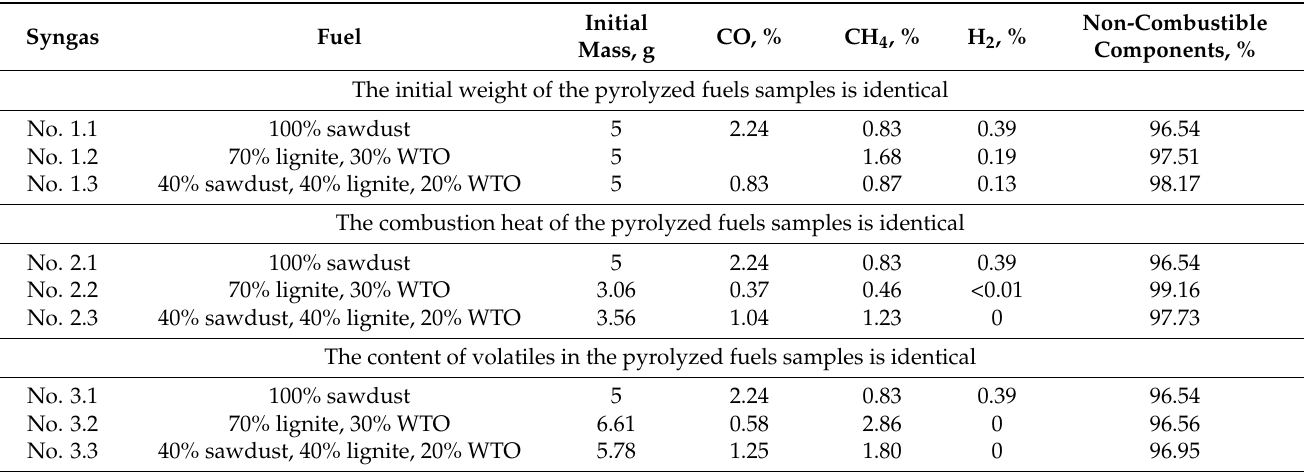
Table 2. Combustible components content in the syngas composition under various conditions for its